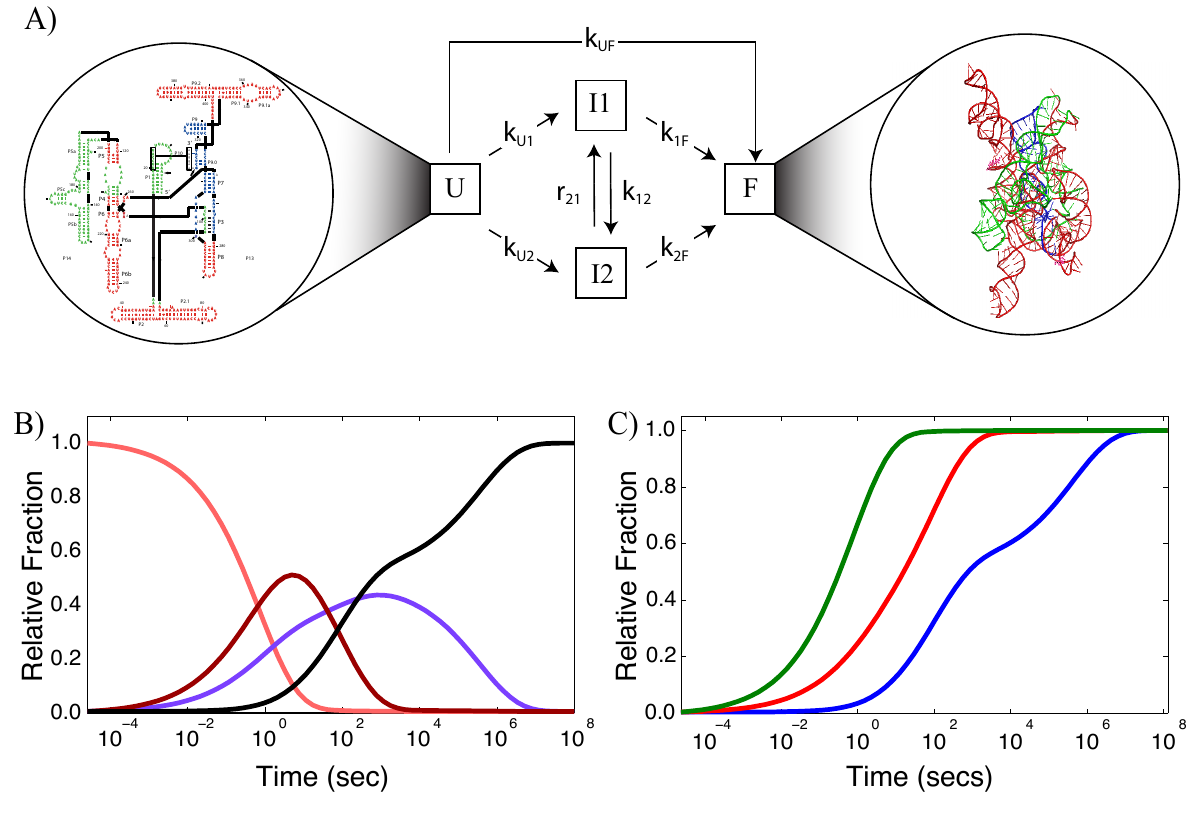
Figure 1. Basic premise for describing an RNA folding reaction with a kinetic model. A.) Unfolded RNA ( U state) has only secondary structure elements formed (secondary structure diagram shown in the left hand circle) while the folded state ( F ) has the full complement of tertiary interactions which allow it to adopt a unique three-dimensional structure (shown in the right hand circle). The folding reaction often takes several hours to go to completion due to multiple intermediates I that populate the pathways to the F state. Each transition between state curves is indicated with an arrow and has a rate constant associated with it. For clarity, we only show the forward transitions in this diagram as the forward rates are generally much larger than the reverse rates. B.) Resulting state curves (cid:126)x ( t ) for U (orange), I 1 (magenta), I 2 (purple) and F (black) that describe the relative fraction of each species as a function of time for the folding of the L-21 T. thermophila group I intron in the presence 10mM MgCl [9]. These curves are obtained from Equation 5. C.) · OH footprinting curves ( (cid:126) C folding of the T. thermophila group I intron in the presence of 10 mM MgCl curve corresponds to the P4P6 subdomain, red to the periphery, and blue to the catalytic core of the molecule; a corresponding color scheme is used to illustrate these subdomains for the structures shown in A. We assume that the progress curves are a result of differrent fractions of the unfolded state and the fully folded